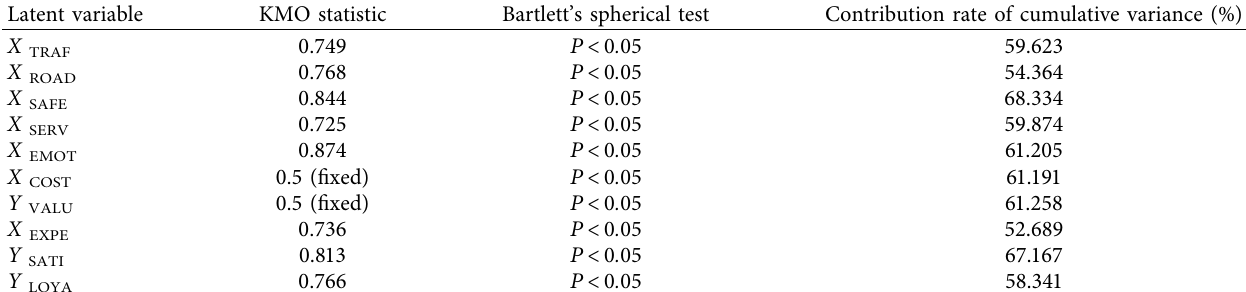
Table 4: Validity testing of model variables.